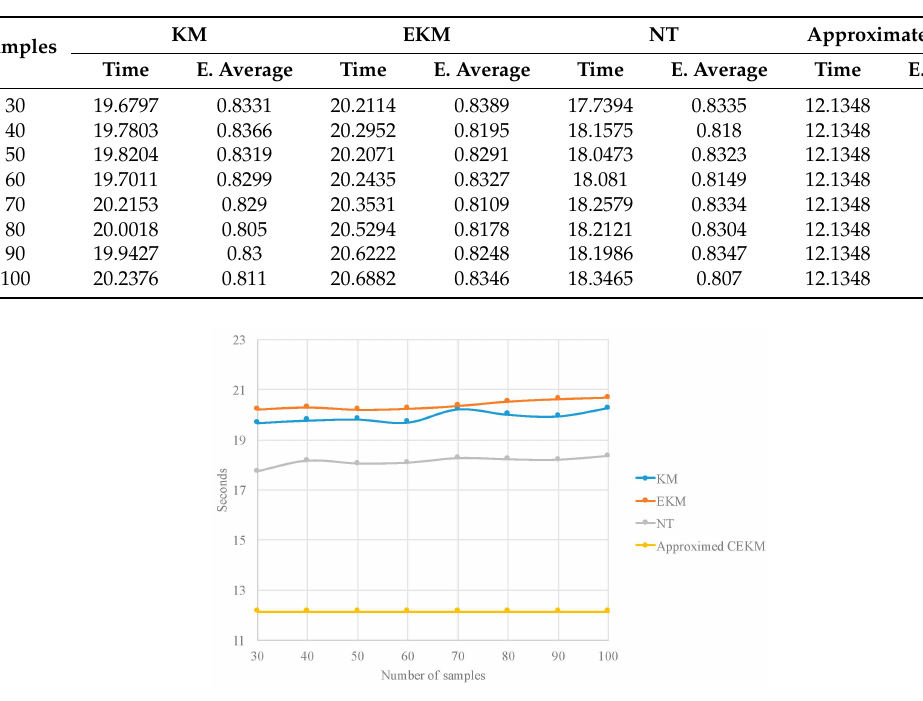
Table 16. Edge detection comparison by variating the type-reduction method.